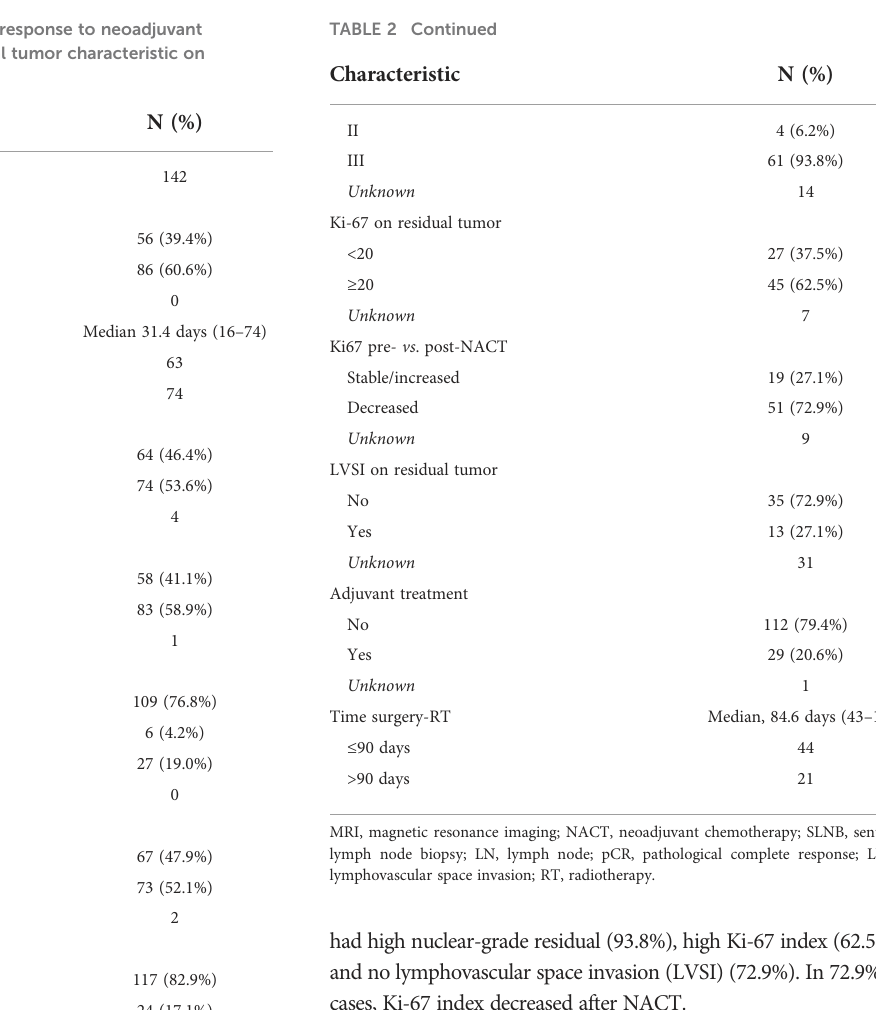
TABLE 2 Treatment characteristics, response to neoadjuvant chemotherapy, and histopathological tumor characteristic on surgical tissue.